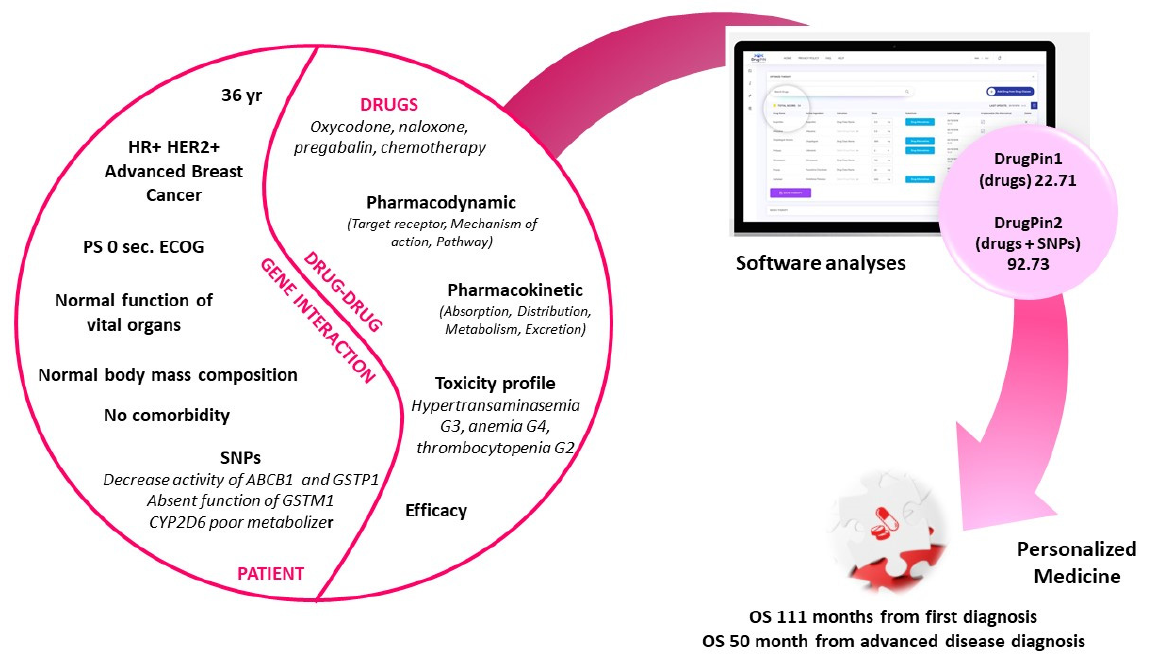
Figure 1. Personalized medicine thanks to new Drug-PIN system comprehensive approach. PS, Performance Status; ECOG, Eastern Cooperative Oncology Group; OS, Overal Survival; SNP, Single Nucleotide polymorphism.